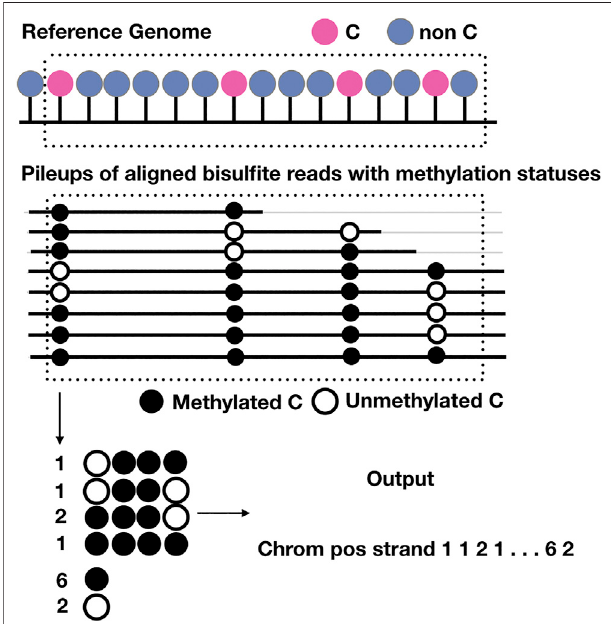
FIGURE 4 | Schematic representation of the output of BSImp. First the reads are aligned to the reference genome, given any window of speci fi ed number of cytosines (here is 4), methylation statuses are extracted and missing values imputed if valid, then methylation pro fi led as a vector including chromosome, position, strand, the copy numbers of all possible methylation patterns starting at the position, and number of methylated and unmethylated